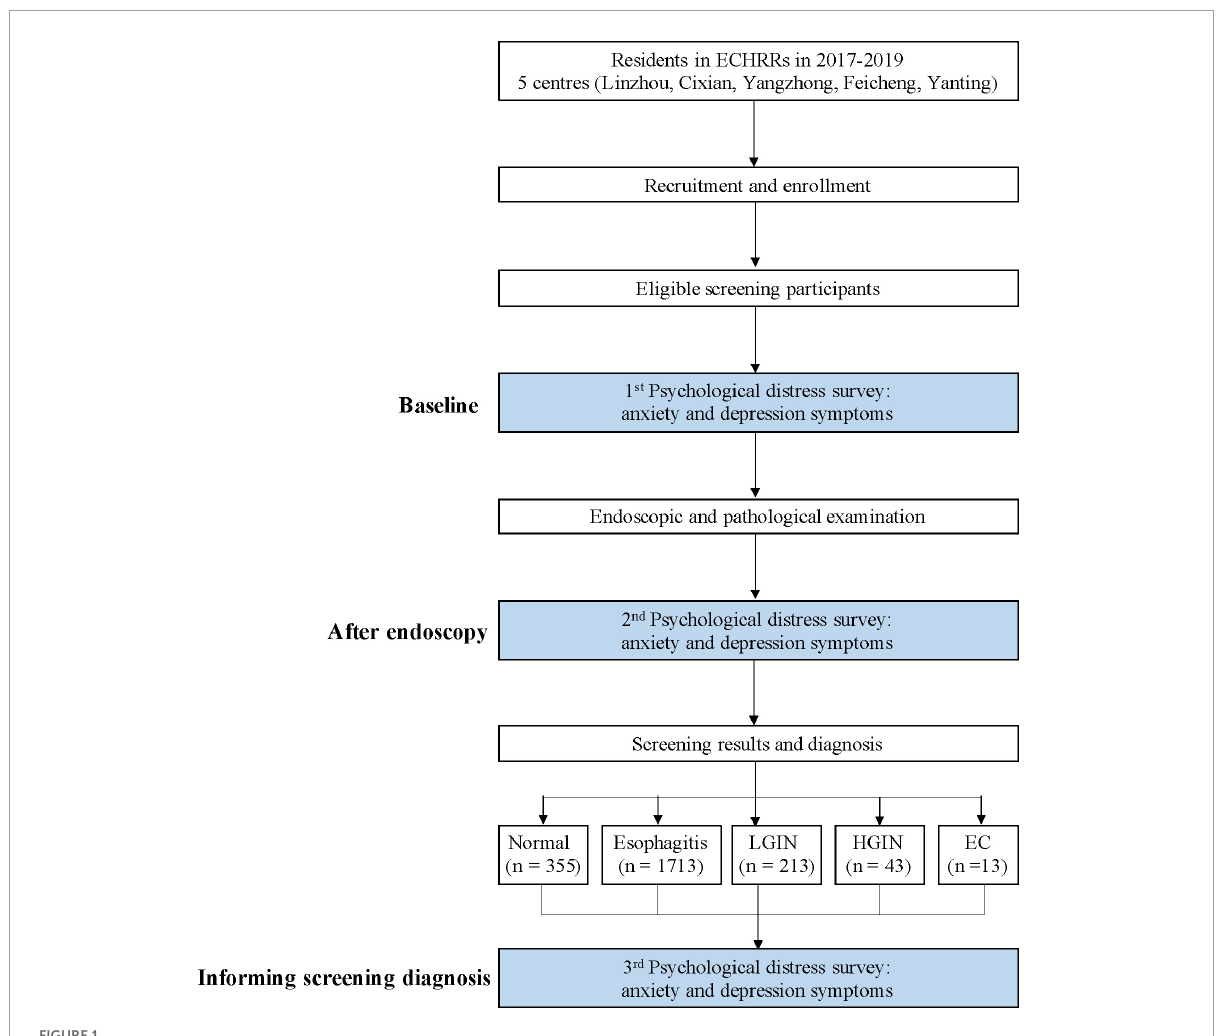
FIGURE1 Flowchart of the